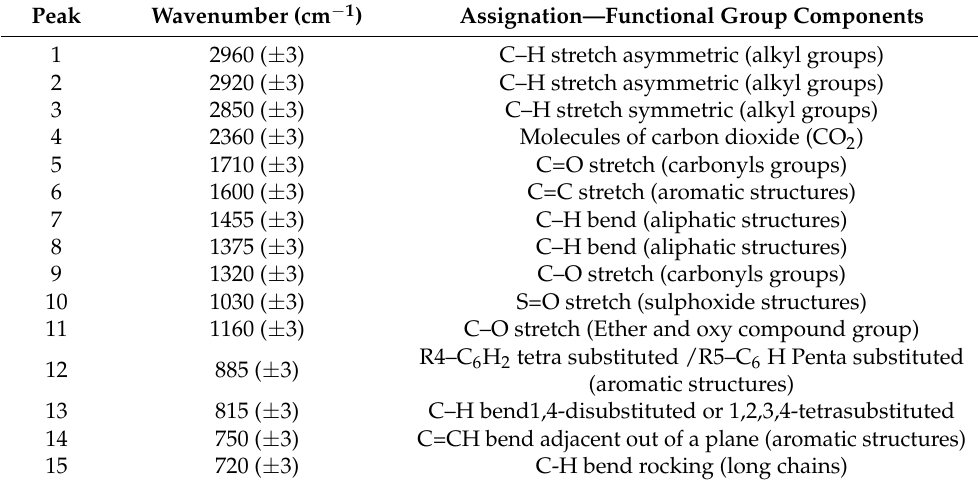
Table 7. ATR-FTIR spectra’s data of bituminous